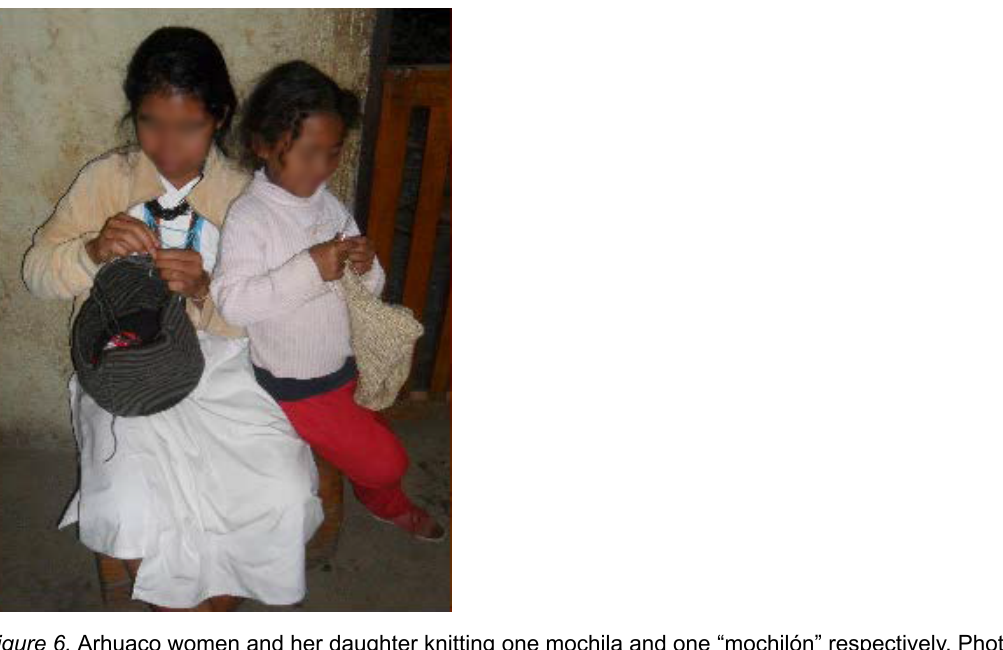
Figure 6. Arhuaco women and her daughter knitting one mochila and one “mochilón” respectively. Photo by Dwrya Izquierdo